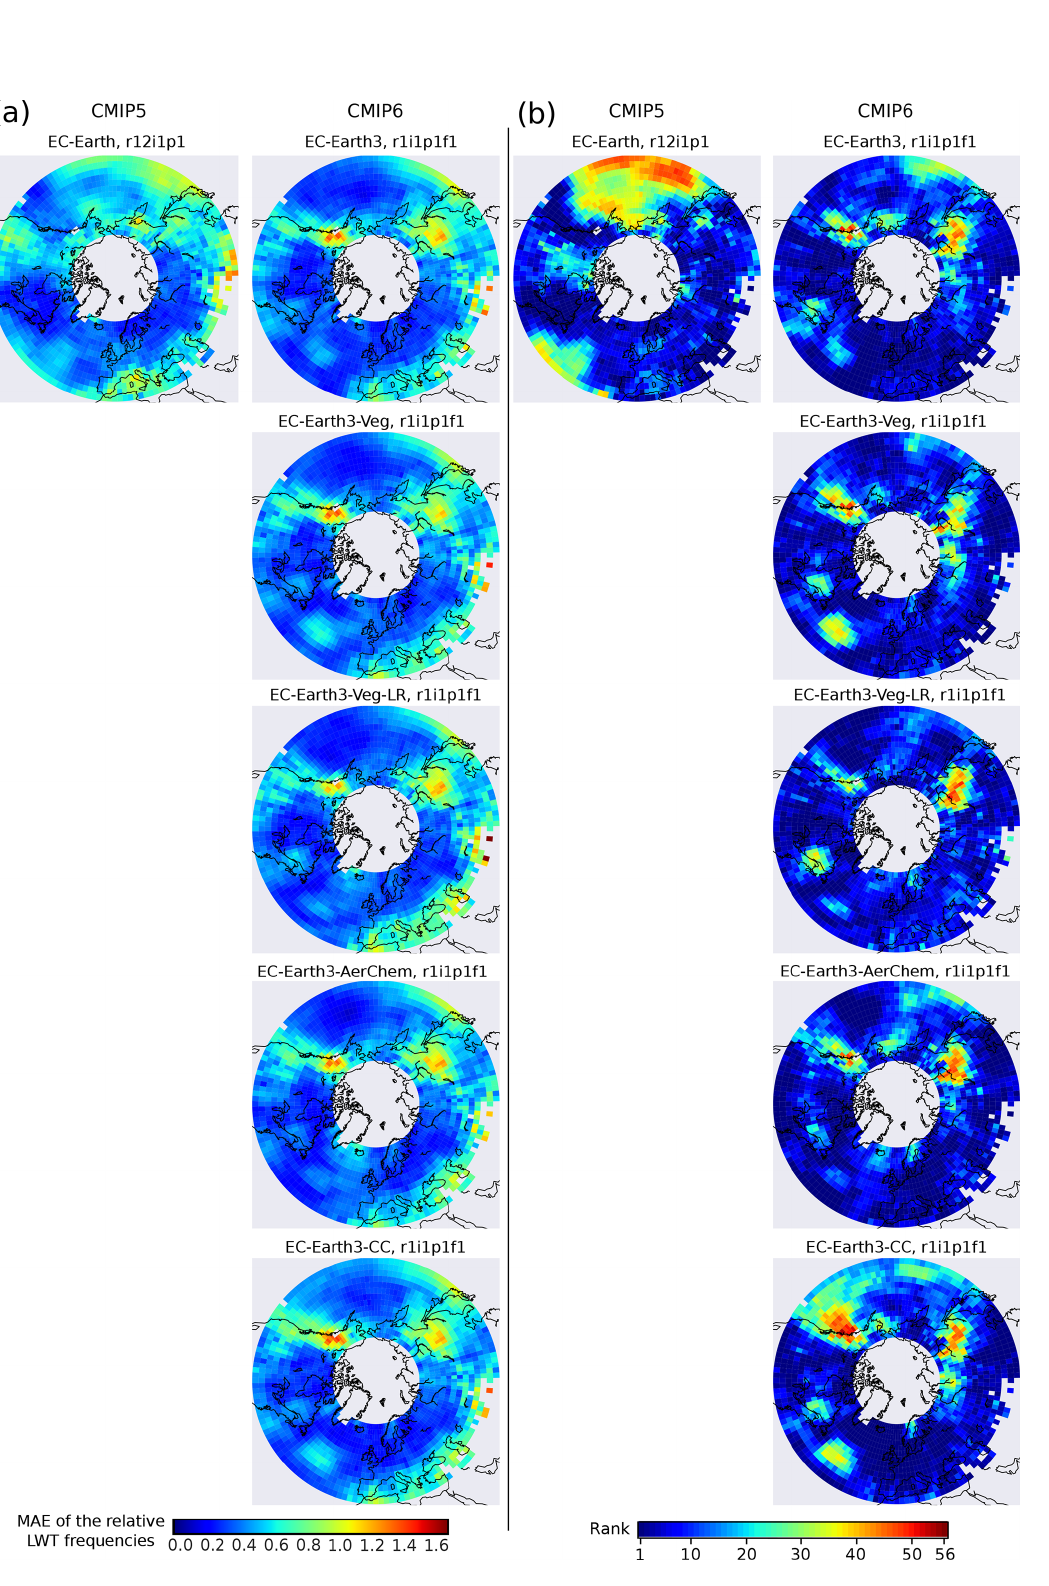
Figure 9. As Fig. 3 but for the EC-Earth models.